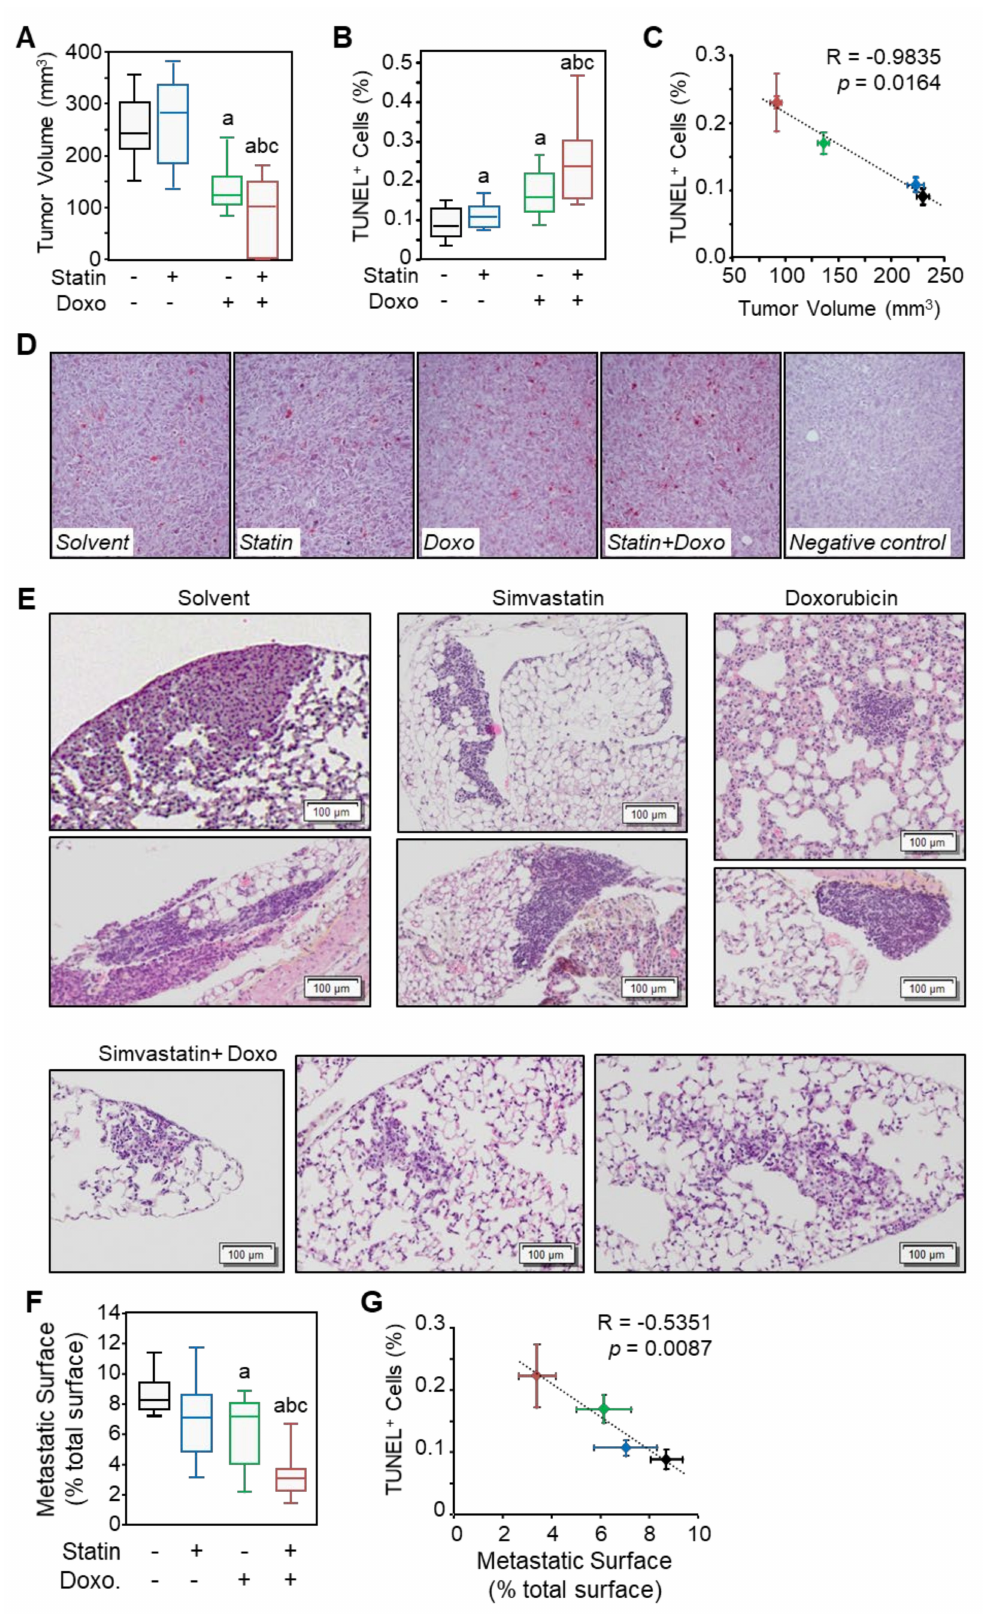
Figure 8. Simvastatin alone does not impair tumor growth and dissemination but enhances the chemotherapy effect. Mice ( n = 6 per group) were injected intramuscularly with murine osteosarcoma cells K7M2 to develop primary tumors. On day 11, randomized mice received saline